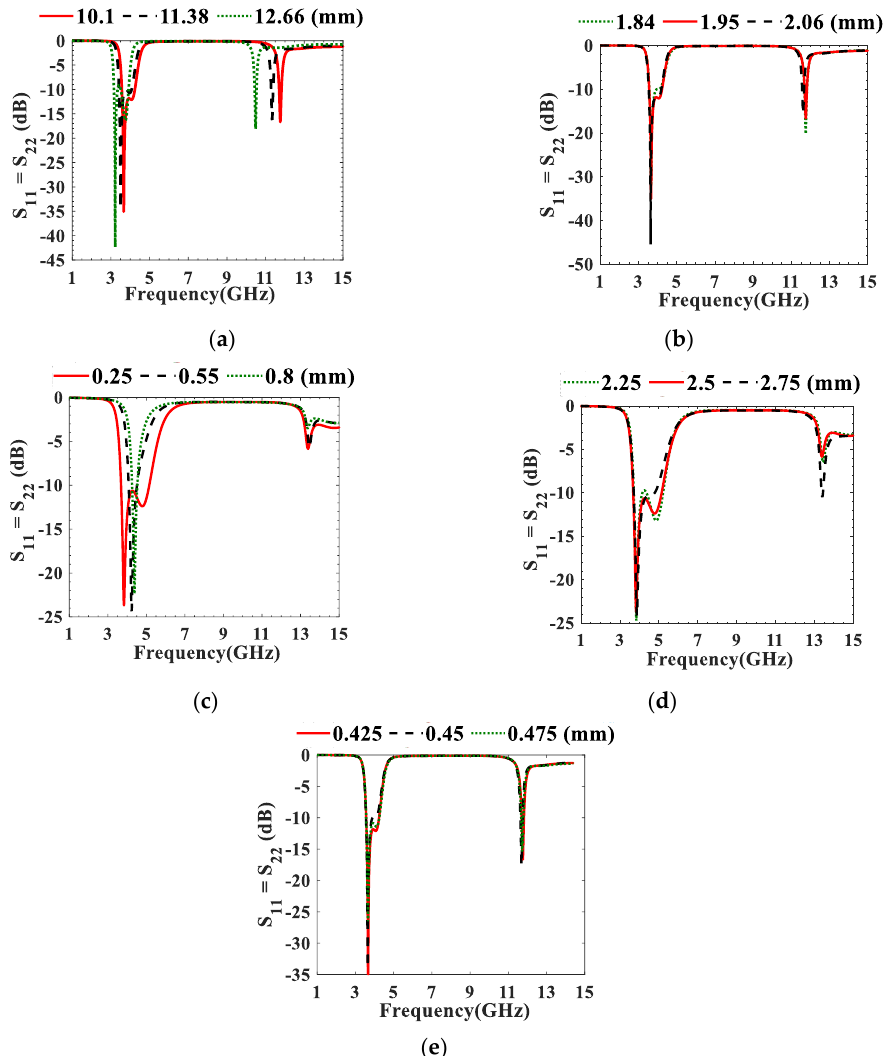
Figure 5. Parametric studies of the proposed UTL IBPF at (3.7 – 4.2 GHz) on (a) L res2 , (b) W res , (c) S , (d) L t , and (e) rVia.